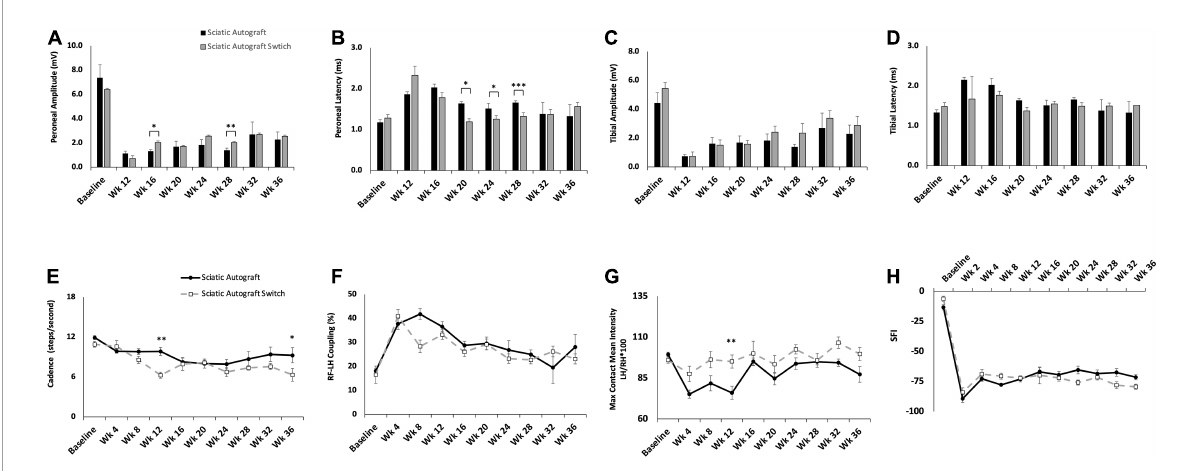
FIGURE3 Compound muscle action potentials (CMAP) and gait analysis of the sciatic autograft and sciatic autograft switch groups. (A) Amplitude recordings of the peroneal branch of the sciatic nerve. (B) Latency recordings of the peroneal branch of the sciatic nerve. (C) Amplitudes recorded from the tibial branch of the sciatic nerve. (D) Latencies of the tibial branch of the sciatic nerve. ∗ p < 0.05, ∗∗ p < 0.01, ∗∗∗ p < 0.001 by repeated measures ANOVA with Tukey post-hoc test. (E) Cadence in steps per second as calculated by the CatWalk software. (F) RF-LH coupling showing the percentage of time the left hind (LH) paw preceded the right front (RF) paw in the step cycle. (G) Measure of the maximum intensity at the point of maximum contact for the left hind paw/right hind paw*100. (H) Sciatic functional index (SFI) recordings as calculated by the CatWalk software. n = 5 for sciatic autograft, n = 6 for sciatic autograft switch, ∗ p < 0.05, ∗∗ p < 0.01 by repeated measures ANOVA with Tukey post-hoc test. Error bars are standard error of the mean (SEM).